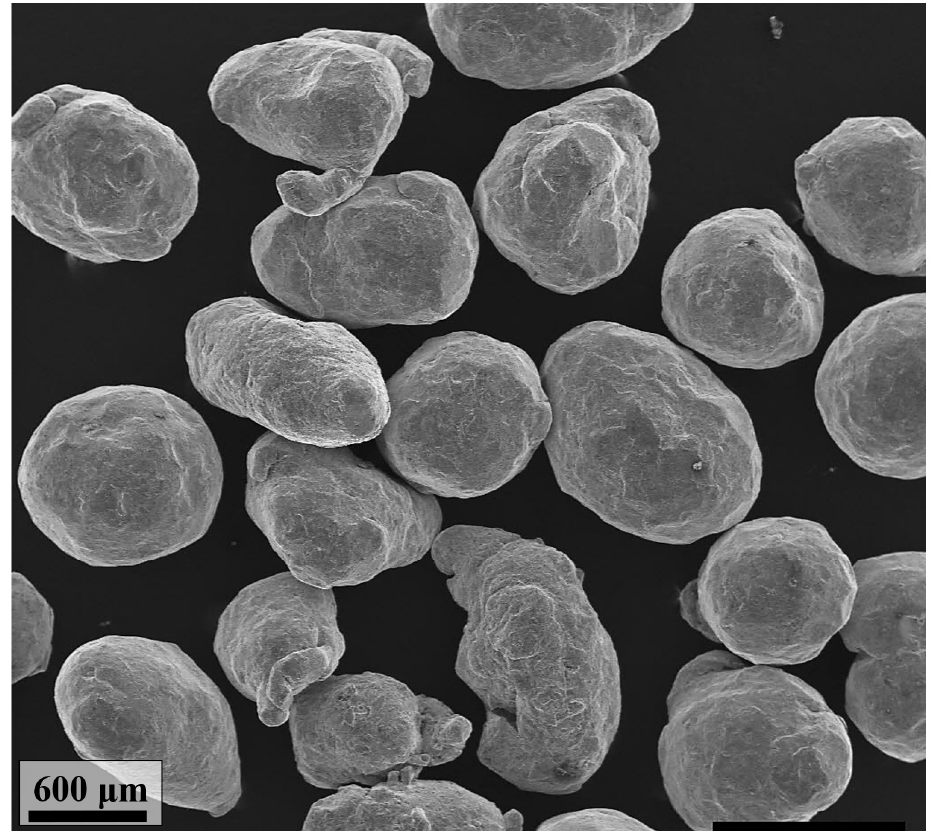
Figure 3. SEM images of stainless-steel shots used for peening.